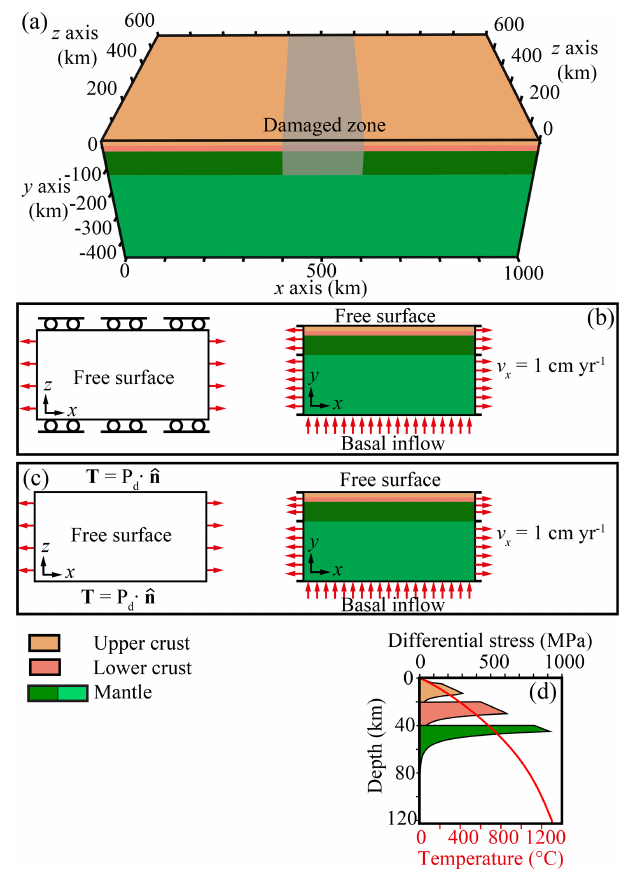
Figure 9. (a) A 3D view of the modelled domain. An initial plas- tic strain with a Gaussian repartition is applied in the central part of the domain in the lithosphere. (b) Map and cross section of the boundary conditions for the model with free-slip boundary condi- tions. (c) Map and cross section of the boundary conditions for the model with normal stress boundary conditions. (d) Yield–stress en- velope and initial temperature of the first